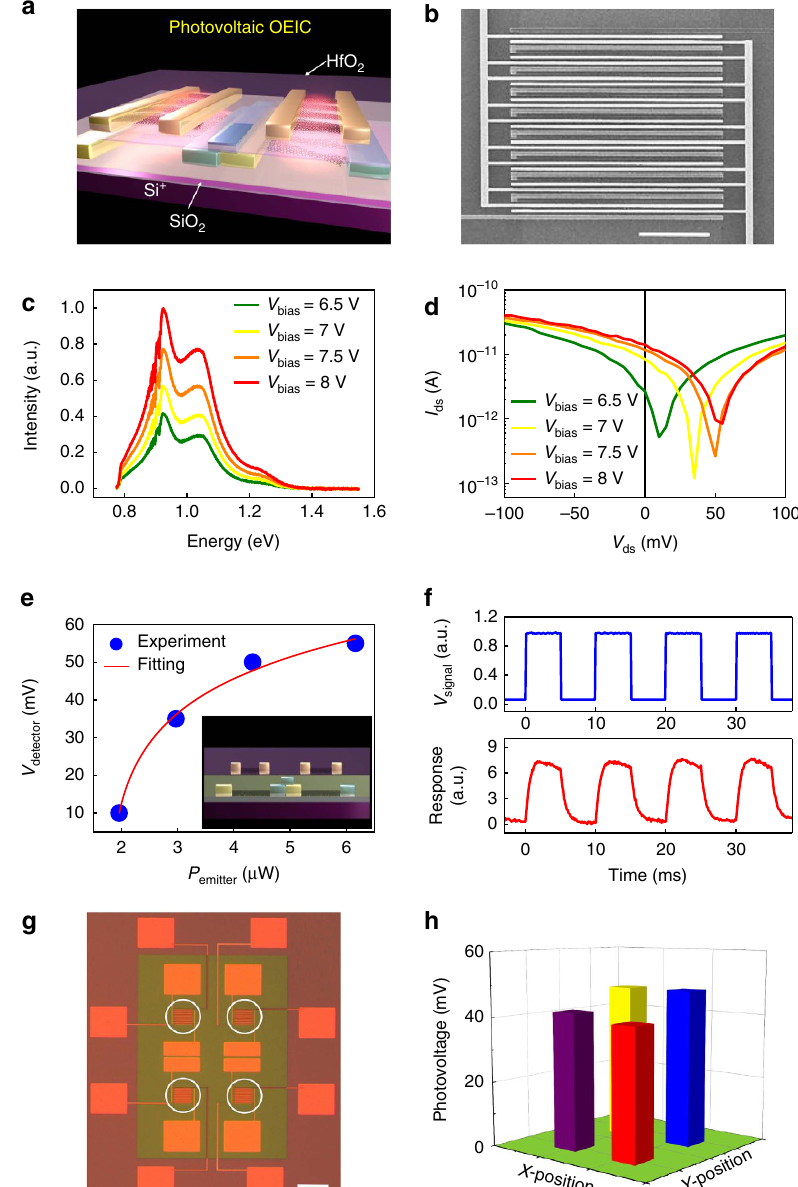
Figure 4 | On-chip vertical near-field OEIC. ( a ) Schematic of the vertical near-field OEIC, consisting of a top-layer emitter and a bottom-layer cascading detector. ( b ) SEM image of the vertical OEIC (scale bar, 10 m m). ( c ) EL spectra of the top-layer emitter. ( d ) Corresponding output characteristics of the bottom-layer photovoltaic detector. ( e ) Photovoltage of the bottom-layer detector versus the illumination power of the top-layer CNTemitter. Inset is the front-view graph of a . ( f ) Dynamic time trace of the 3D OEIC. ( g ) Optical image of the 2 (cid:2) 2 vertical parallel-transmission array (scale bar, 50 m m). Each white circle denotes an active CDM channel region. ( h ) Corresponding parallel-transmission mapping result of the 2 (cid:2) 2 CDM mapping